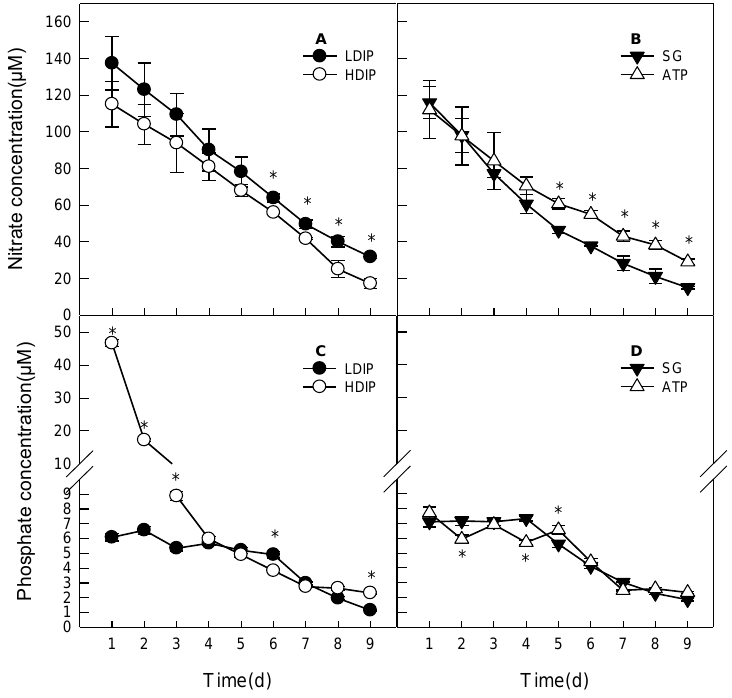
Figure 6. Changes of concentration of nitrate and phosphate in the water of C. roscoffensis culture in groups of inorganics ( A , C ) and organic ( B , D ) initial phosphorus resources. (LDIP): low concentration of inorganic phosphorus; (HDIP): high concentration of inorganic phosphorus; (SG): Na 2 -glycerophosphate; (ATP): adenosine triphosphate. * statistical significance, p < 0.05.